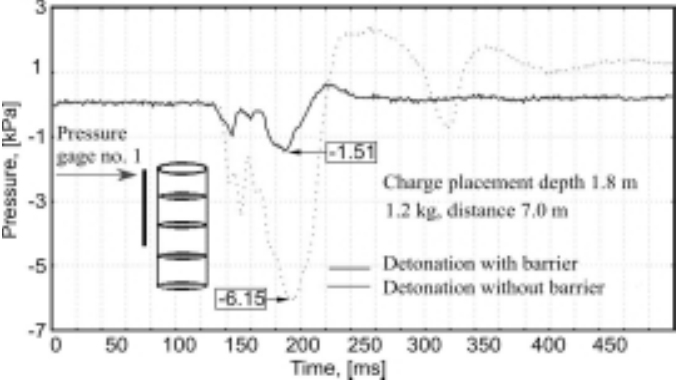
Fig. 10. Time histories of pressures p h on the structure front, measured by Gage No. 1 from a detonation at 7.0 m from the silo.